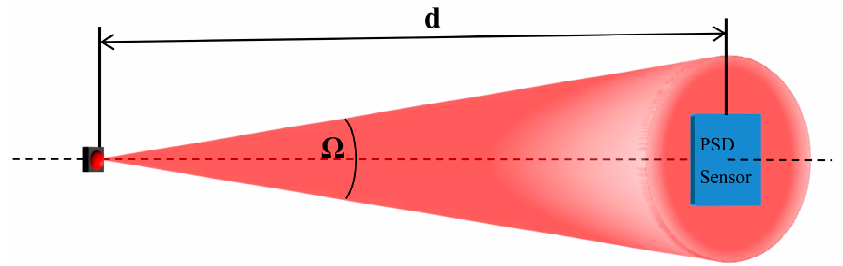
Figure 18. Uniform illumination of the PSD sensor.